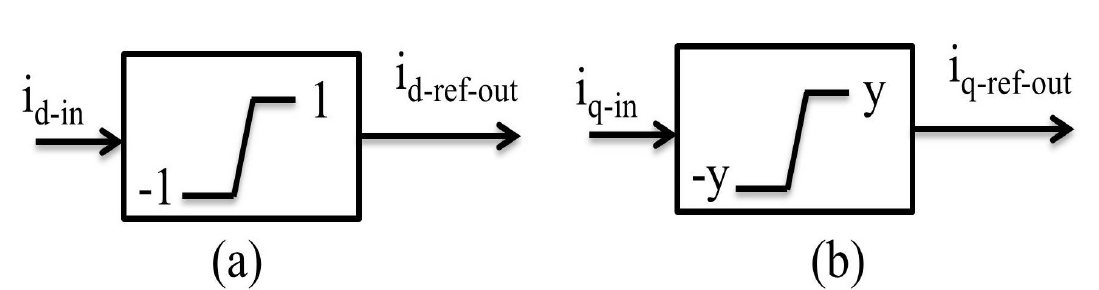
Figure 5. Active ( a ) and reactive ( b ) power calculation at converter